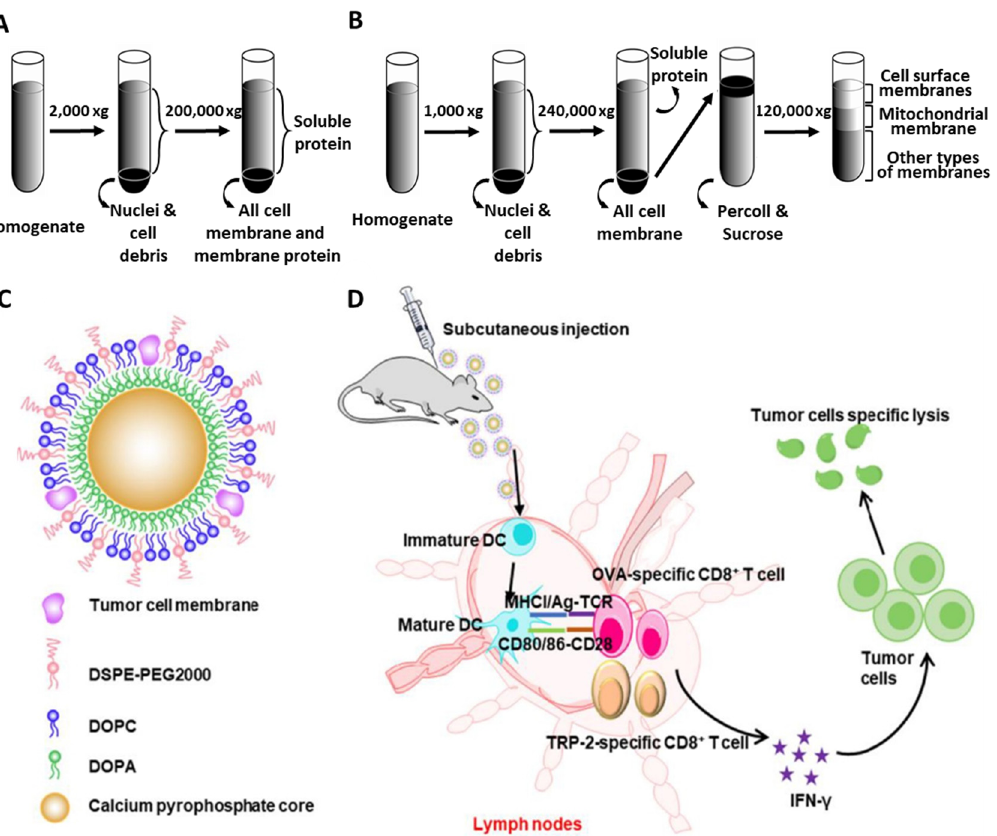
Figure 3. Schematic illustration of tumor cell membrane isolation and application in anticancer immunotherapy. ( A ) Cell membrane isolation using ultracentrifugation to obtain the total cell membrane component, ( B ) sucrose-dependent isolation for separating the cell surface membrane components, ( C ) design of tumor cell membrane-coated CaPyro nanoparticle, and ( D ) anticancer immunity mechanism using these NPs. All subfigures were reproduced with permission from Refs.